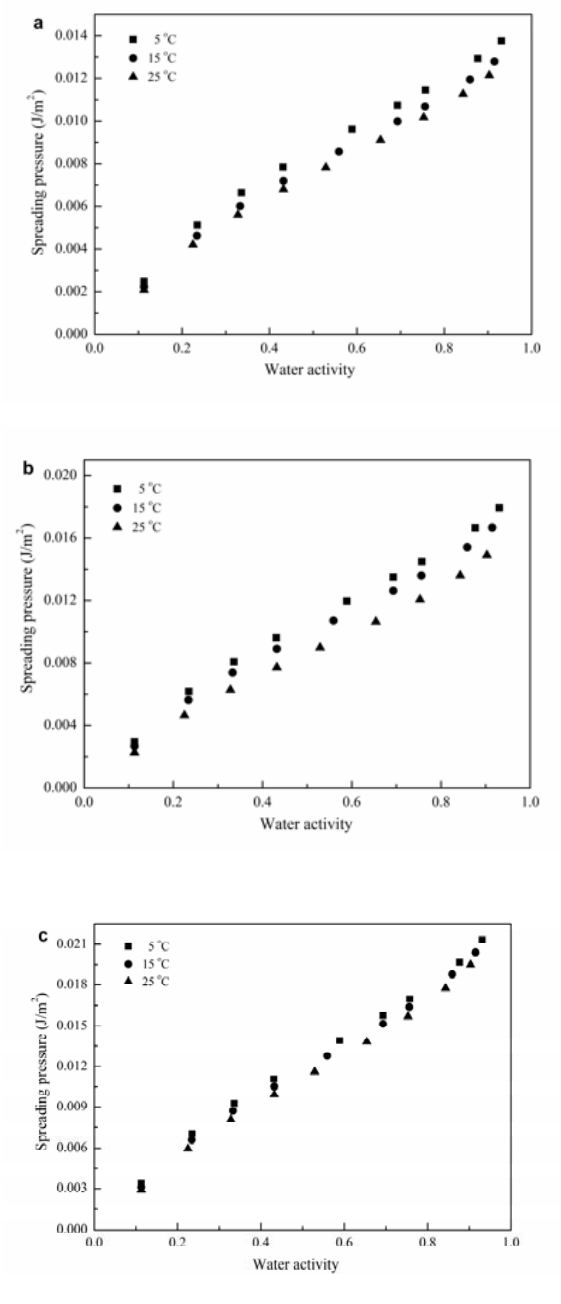
Figure 3. Spreading pressure as a function of water activity of for GG ‐ based films at different values of water activity; ( a ) GG ‐ P, ( b ) GG ‐ G, and (c ) GG ‐ G ‐ N.